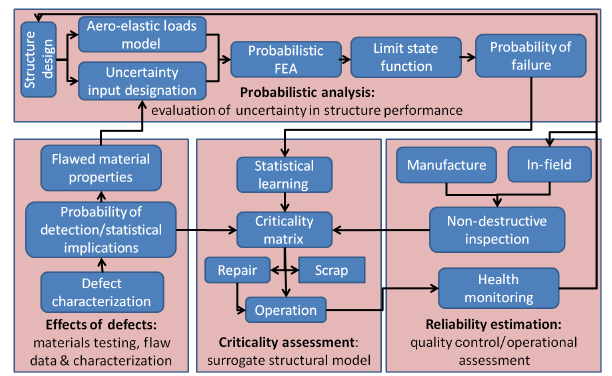
Figure 2. Conceptual flow diagram of probability reliability proto- col (PReP)